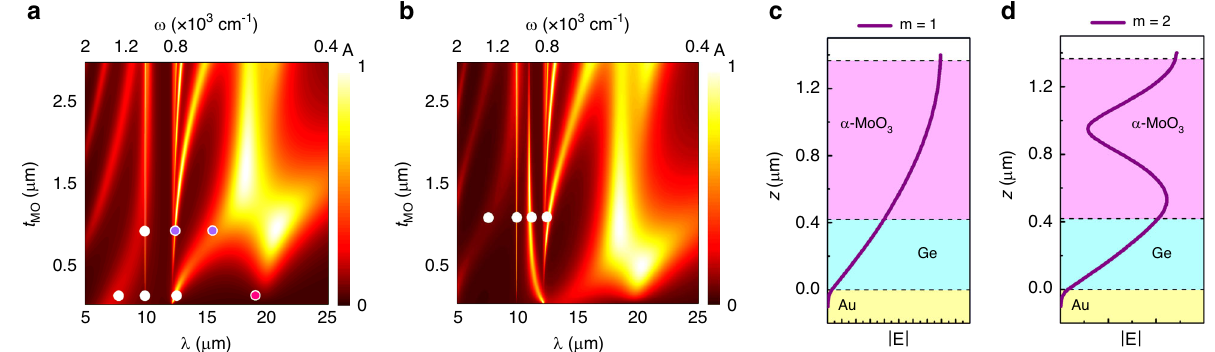
Fig. 3 Dispersion of α -MoO 3 FP cavity with t MO . Simulated absorption versus wavelength/frequency and α -MoO 3 thickness ( t MO ) in the multilayer structure for constant Ge thickness ( c ) t Ge = 0.42 μ m and ( d ) t Ge = 0.85 μ m where ϕ i = 0°. Simulated electric fi eld magnitude | E | in the cross section of the studied multilayer system for t MO = 0.15 μ m and t Ge = 0.42 μ m at ( c ) ω = 660 cm − 1 ( m = 1) and ( d ) ω = 805 cm − 1 ( m = 2). The dots in panels a and